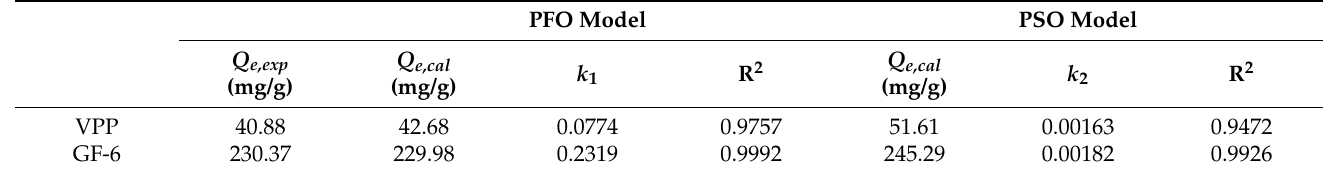
Figure 7. Adsorption kinetics of AmZPP 5000 for VPP ( a , c ) and GF-6 ( b , d ) fitting by PFO, PSO and IPD models. Table 1. Kinetic parameters for VPP and GF-6 adsorption on AmZPP 5000